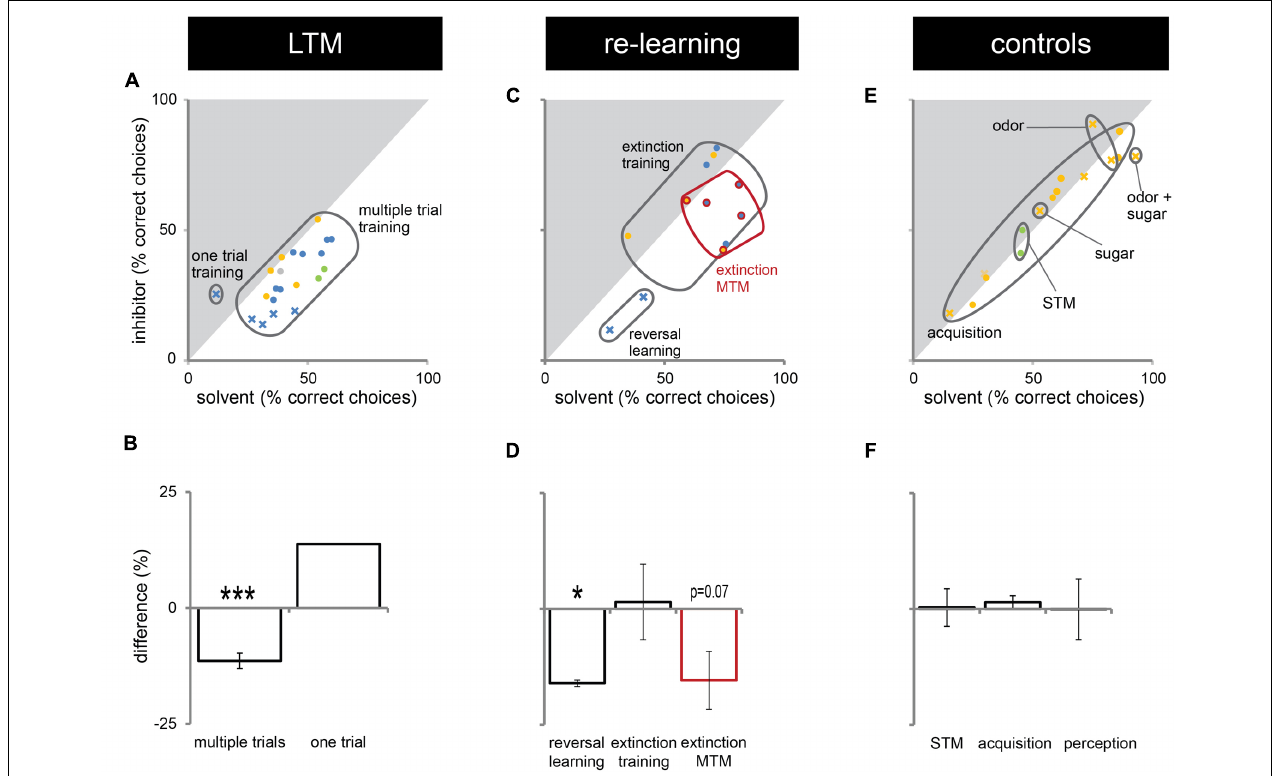
FIGURE 5 | Correct long-term memory (LTM) formation and relearning are both facilitated by Dnmts. All PER experiments shown in this study, published previously (Lockett et al., 2010; Biergans et al., 2012, 2015) or performed additionally (summarized in Supplementary Table S1 ), were re-analyzed in order to gain an overview of which roles of Dnmts are best supported by the data. The % of bees responding ‘correctly’ was calculated for the treatment and control groups. What a ‘correct’ response was differed between experiments ( Table 1 ). (A,C,E) The % of correct responses for the solvent and inhibitor treated groups are plotted against each other. Each mark represents one experiment (inhibitor: X = RG108, O = zebularine; treatment time-point: yellow = before; green = before + after; blue = after training). (A) Solvent treated bees responded ‘correctly’ more often than inhibitor treated bees in most experiments testing LTM retention after multiple trial olfactory reward conditioning. (B) Pooling the difference between the ‘correct’ responses in inhibitor and solvent treated bees of all experiments shows a significant effect of Dnmt activity ( n = 21). (C,D) Reversal learning ( n = 2) and extinction MTM ( n = 5) were most consistently impaired by Dnmt inhibition, whereas the results for extinction learning ( n = 5) were inconsistent. (E,F) Control experiments so far tested the effect of Dnmt inhibition on STM, acquisition, and perception. There was no consistent effect on either [ n (STM) = 2, n (Acquisition) = 10, n (Perception) = 4]. ∗ p -value < 0.05; ∗∗∗ p -value < 0.001.